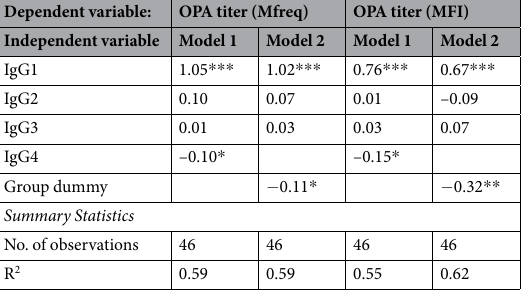
Table 1. Linear regression model for factors contributing to OPA. * p < 0.05; ** p < 0.01; *** p <